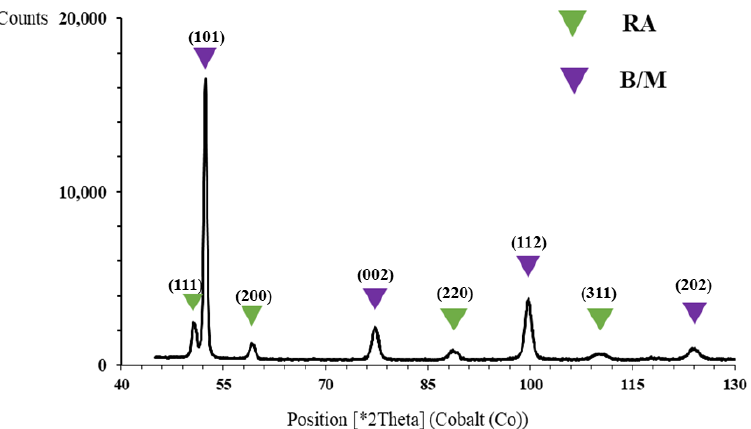
Figure 10. The X-ray diffraction (XRD) pattern of the Q&B specimen. The intensity peaks of FCC RA are shown with green symbols, while the intensity peaks of BCC bainite/martensite (B/M) are shown with purple symbols.